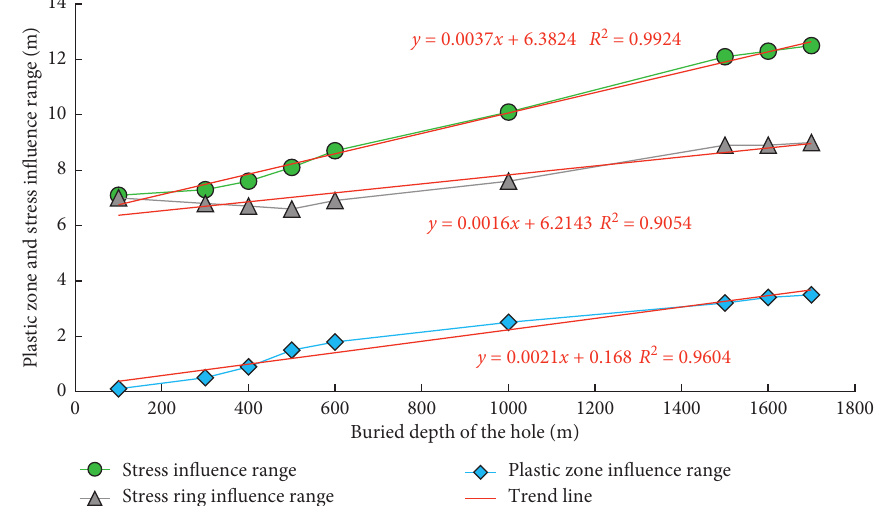
Figure 10: Relationship between plastic zone range and stress influence range of rectangular hole section.